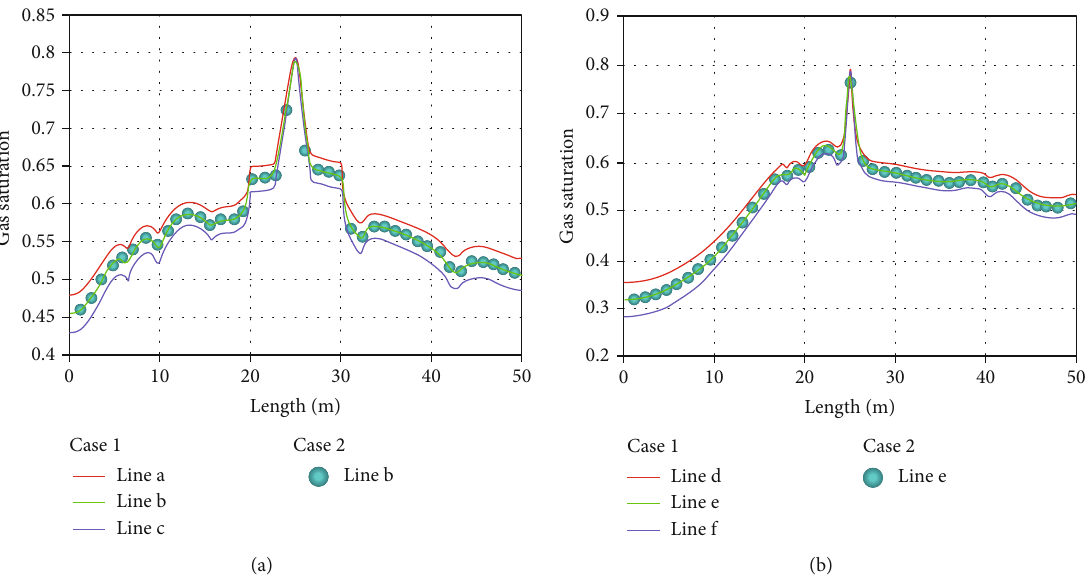
Figure 13: Gas saturation along the lines in the (a) x - and (b) y -directions after 50 days of production.